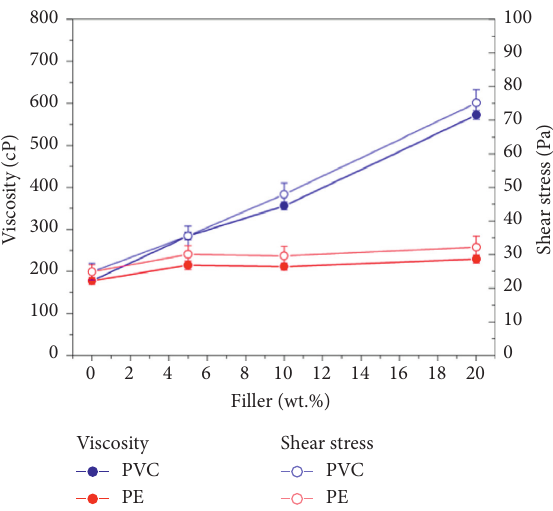
Figure 1: Average viscosity and sheer stress of PS-PVC and PS-PE blends as a